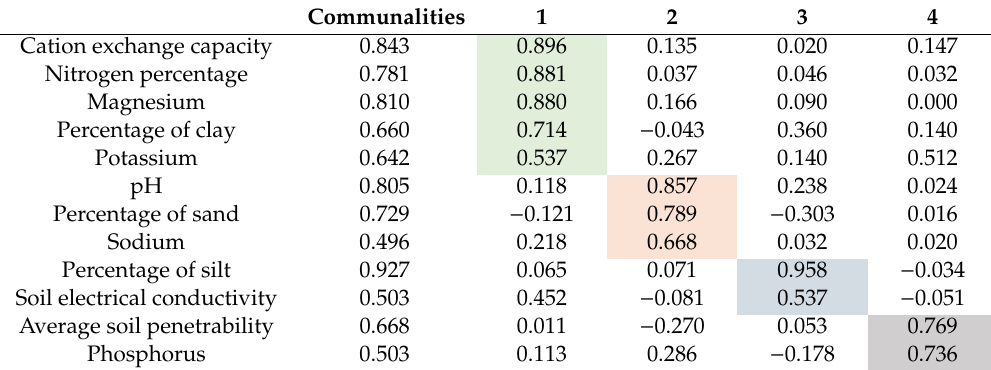
Table 2. Rotated component matrix of principal component analysis of the soil